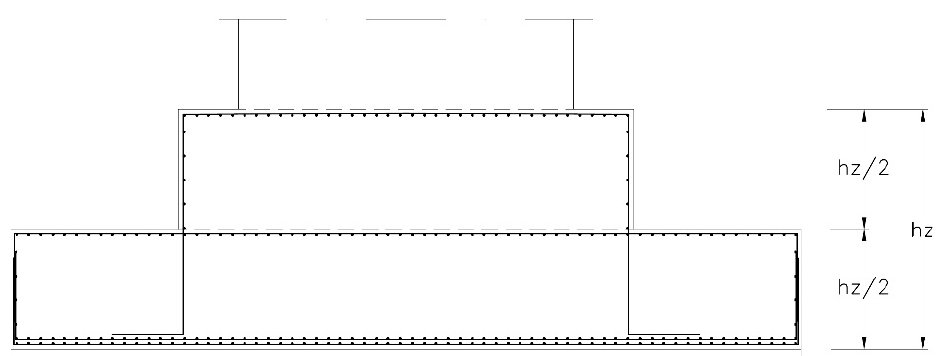
Figure 7. Cross section of the footing foundation.